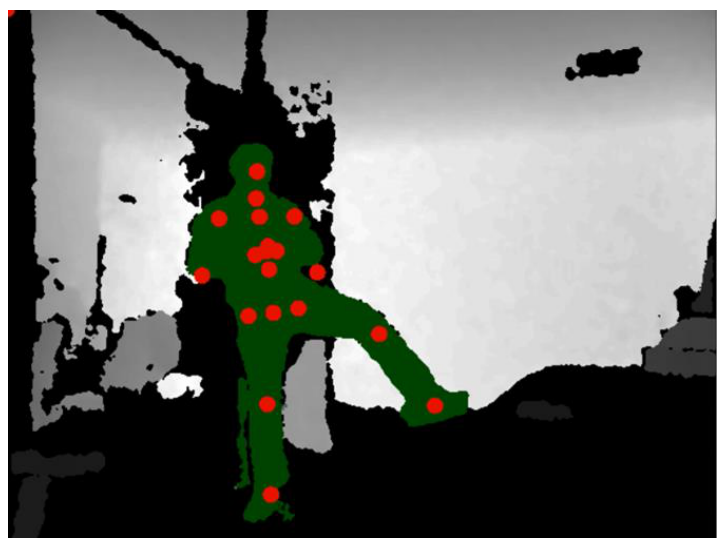
Figure 5. Identification of skeletal joints with Nuitrack™ middleware, via depth sensor.